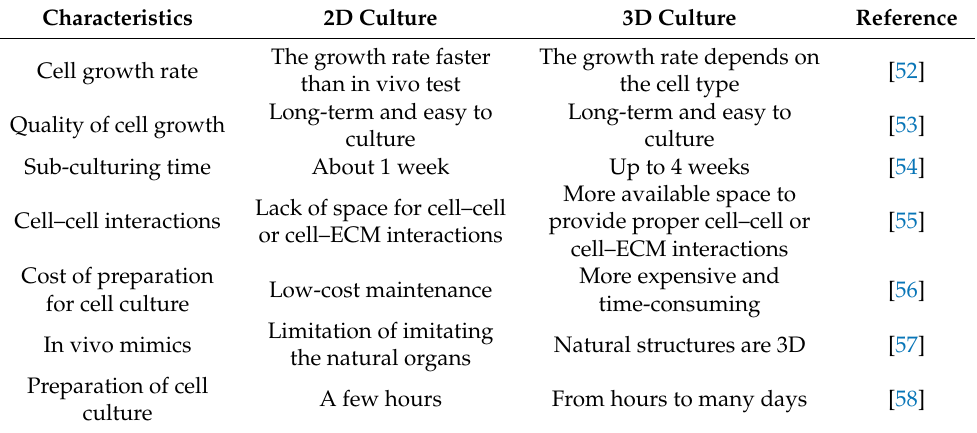
Table 1. The advantages and disadvantages of 2D and 3D cell culture models.